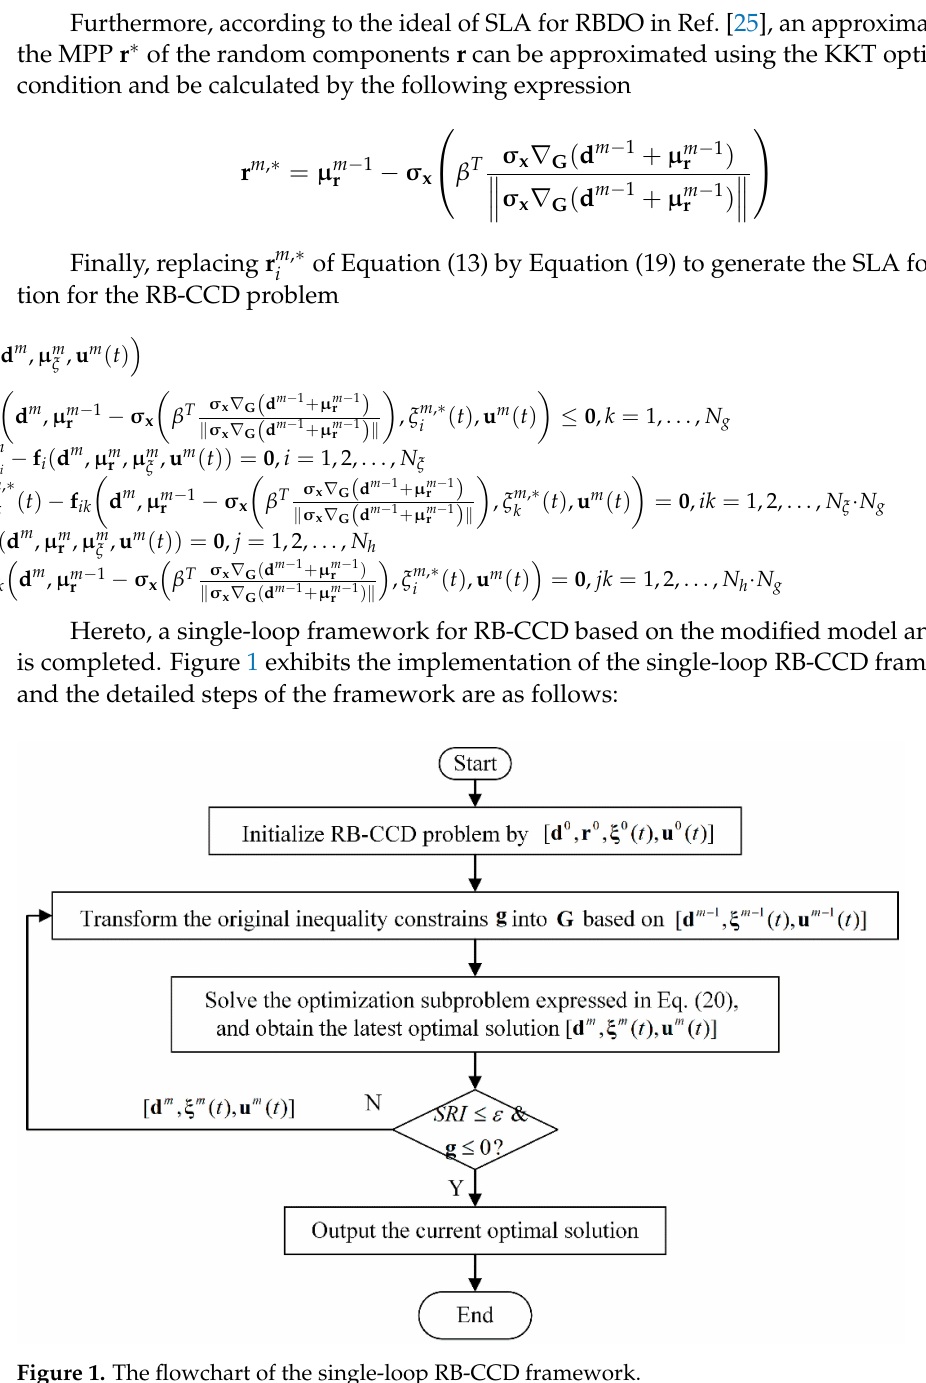
Figure 1. The flowchart of the single-loop RB-CCD framework. Step 1: Solve the CCD problem without considering the uncertainty of the plant design variables x p , and the solution values [ d 0 , ξ 0 ( t ) , u 0 ( t )] are assigned as the initial values for the RB-CCD problem. Step 2: Transform the original inequality constraints g into G of Equation (18)